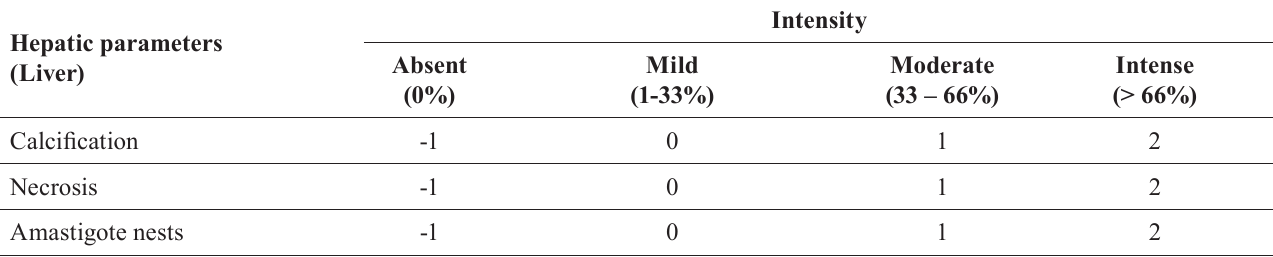
TABLE III - Numerical criteria for the classification of splenic parameters according to the